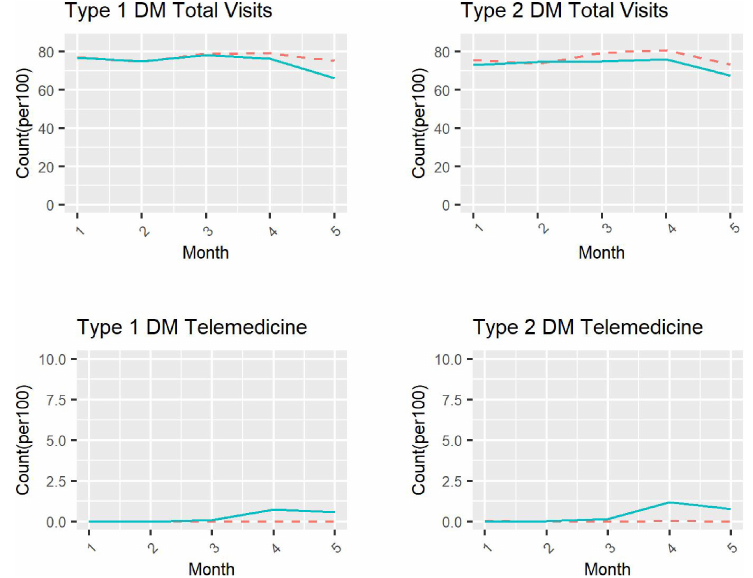
Figure 1. Changes in overall visits and telemedicine use among patients with diabetes from January to May, 2019 and 2020 Solid line shows the number of visits / 100 population in 2020. Dashed line shows the number of visits / 100 population in